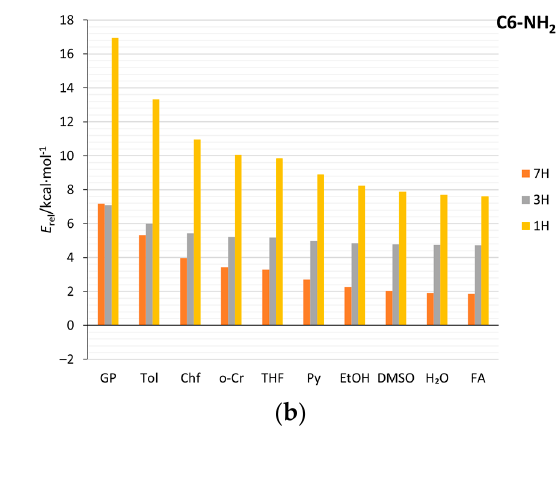
* Data taken from [59]. ** Data taken from [65].